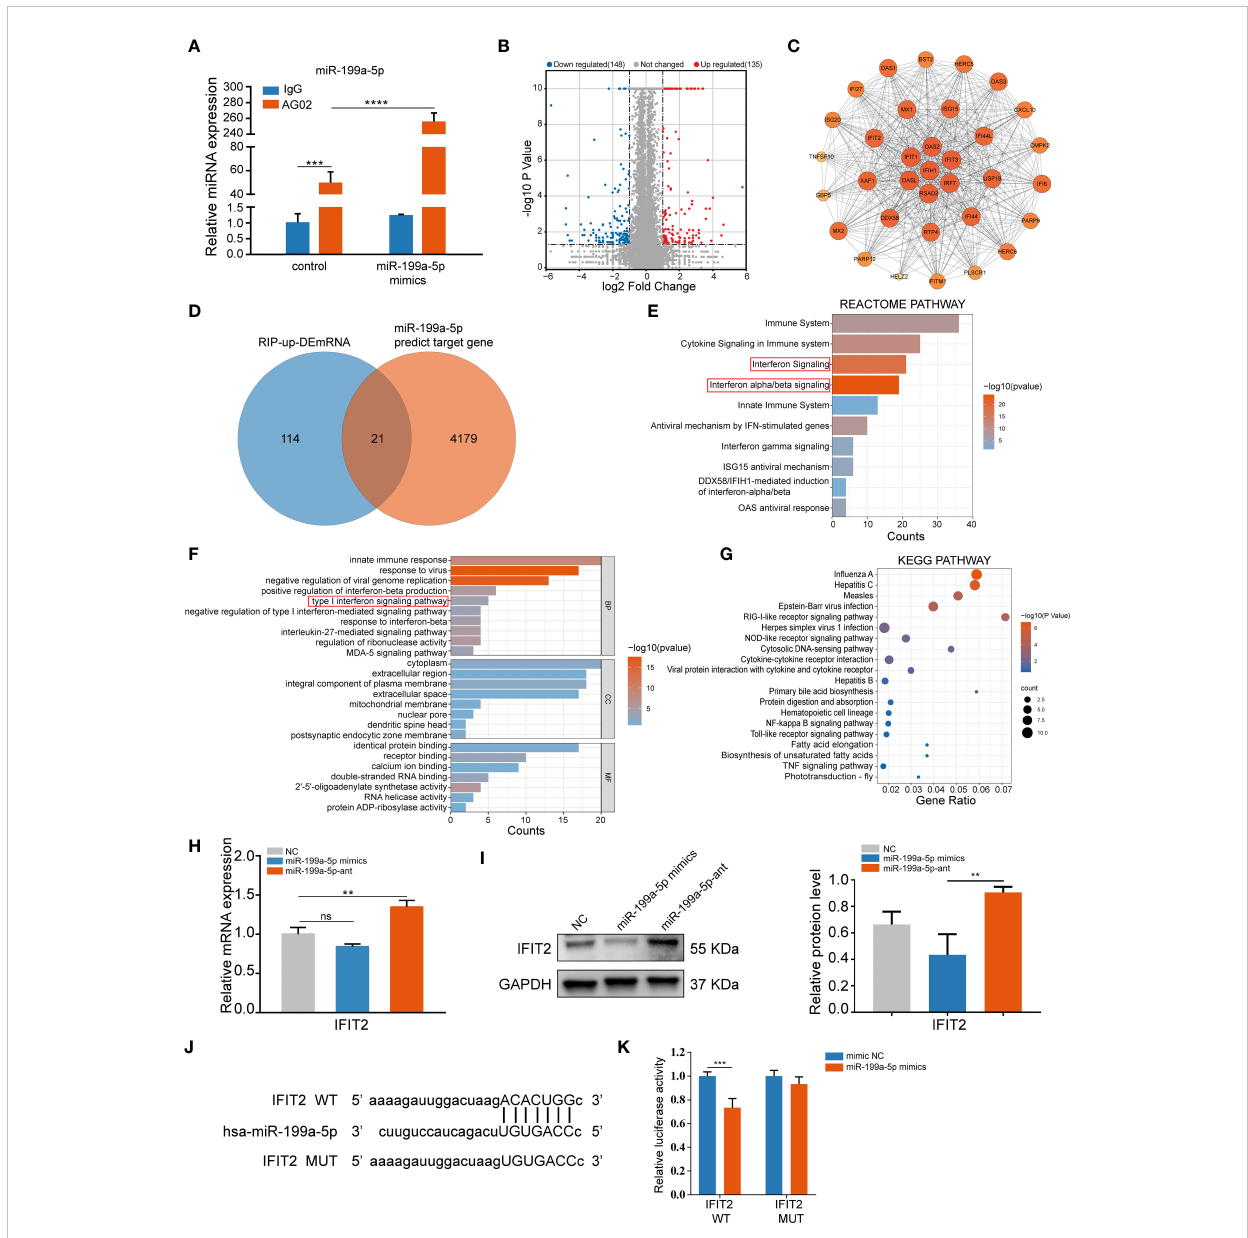
FIGURE 4 miR-199a-5p directly targets IFIT2 in hSCAPs. (A) The relative expression level of miR-199a-5p in immunoprecipitates. (B) The volcano plot of differentially enriched mRNAs in the Ago2 immunoprecipitation complex between the miR-199a-5p overexpression and the control group. (C) Protein-Protein Interaction (PPI) analysis of the up-regulated genes. (D) Venn diagram of the intersection genes between the signi fi cantly up- regulated mRNAs (blue) and the predicted target genes of miR-199a-5p (orange). (E) Reactome pathway analysis of the up-regulated mRNAs. (F) GO analysis of the up-regulated mRNAs. (G) KEGG pathway enrichment analysis of the up-regulated mRNAs. (H) The relative expression level of IFIT2 at mRNA levels. (I) The protein expression levels of IFIT2. (J) Potential binding sites between lFIT2 and miR-199a-5p. (K) Dual-luciferase reporter assay. The data were shown as mean ± SD. ** p < 0.01, *** p < 0.001, and **** p < 0.0001, ns, no signi fi